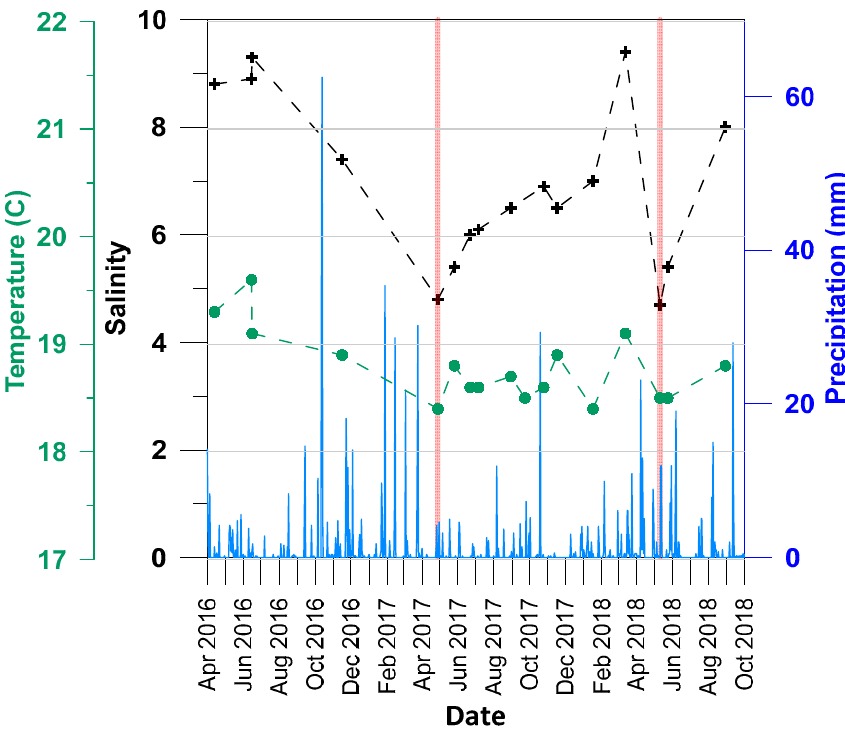
Figure 2. Salinity and temperature of the karstic spring waters and precipitation (daily averages recorded at the nearby Leucate station; https://www.infoclimat.fr/) during the period of observation (2016–2018). The two red vertical bars point to the two salinity minima.